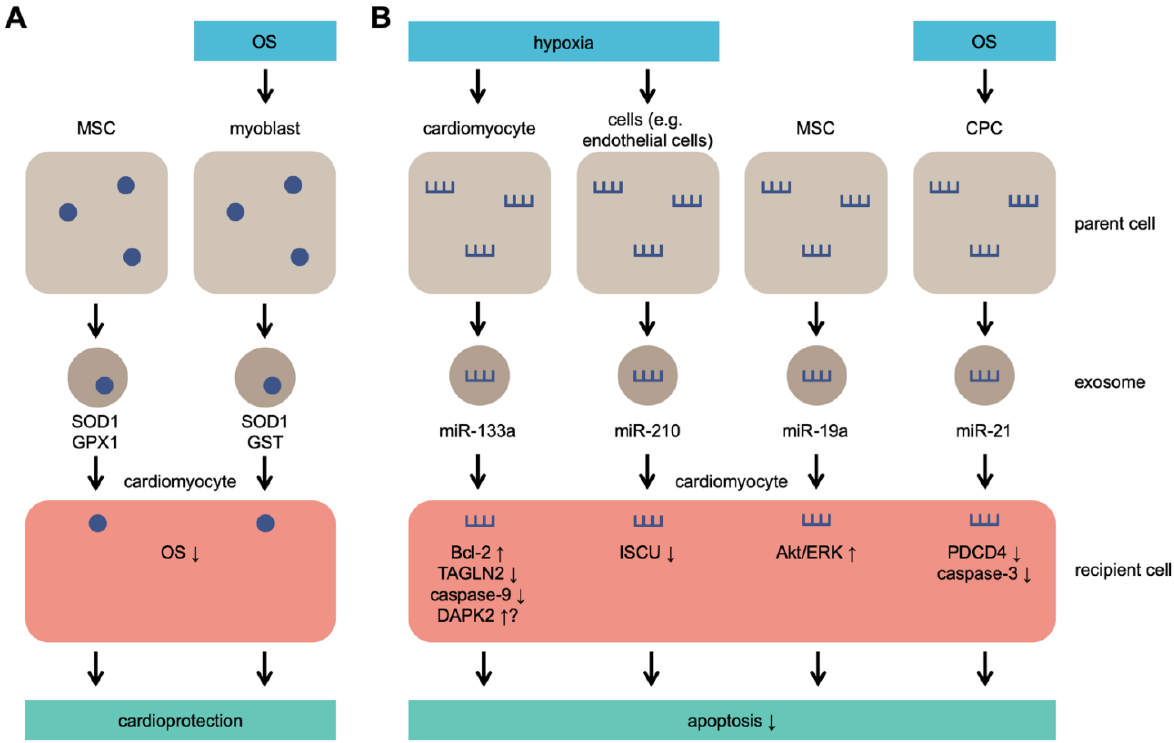
Figure 1. Exosome secretion under OS. Parent cells secrete exosomes containing antioxidant molecules that lead to cardioprotection ( A ) and/or microRNAs (miRs) that lead to inhibition of apoptosis ( B ). MSCs secrete SOD1, GPX1, and miR-19a without OS or hypoxia and protect cardiomyocytes exposed to OS. MSC: mesenchymal stem cells; CPC: cardiac progenitor cell; SOD1: superoxide dismutase 1; GPX1: glutathione peroxidase 1; GST: glutathione S-transferase; TAGLN2: transgelin 2; DAPK2: death-associated protein kinase 2; ISCU: iron–sulfur cluster assembly enzyme; PDCD4: programmed cell death 4.